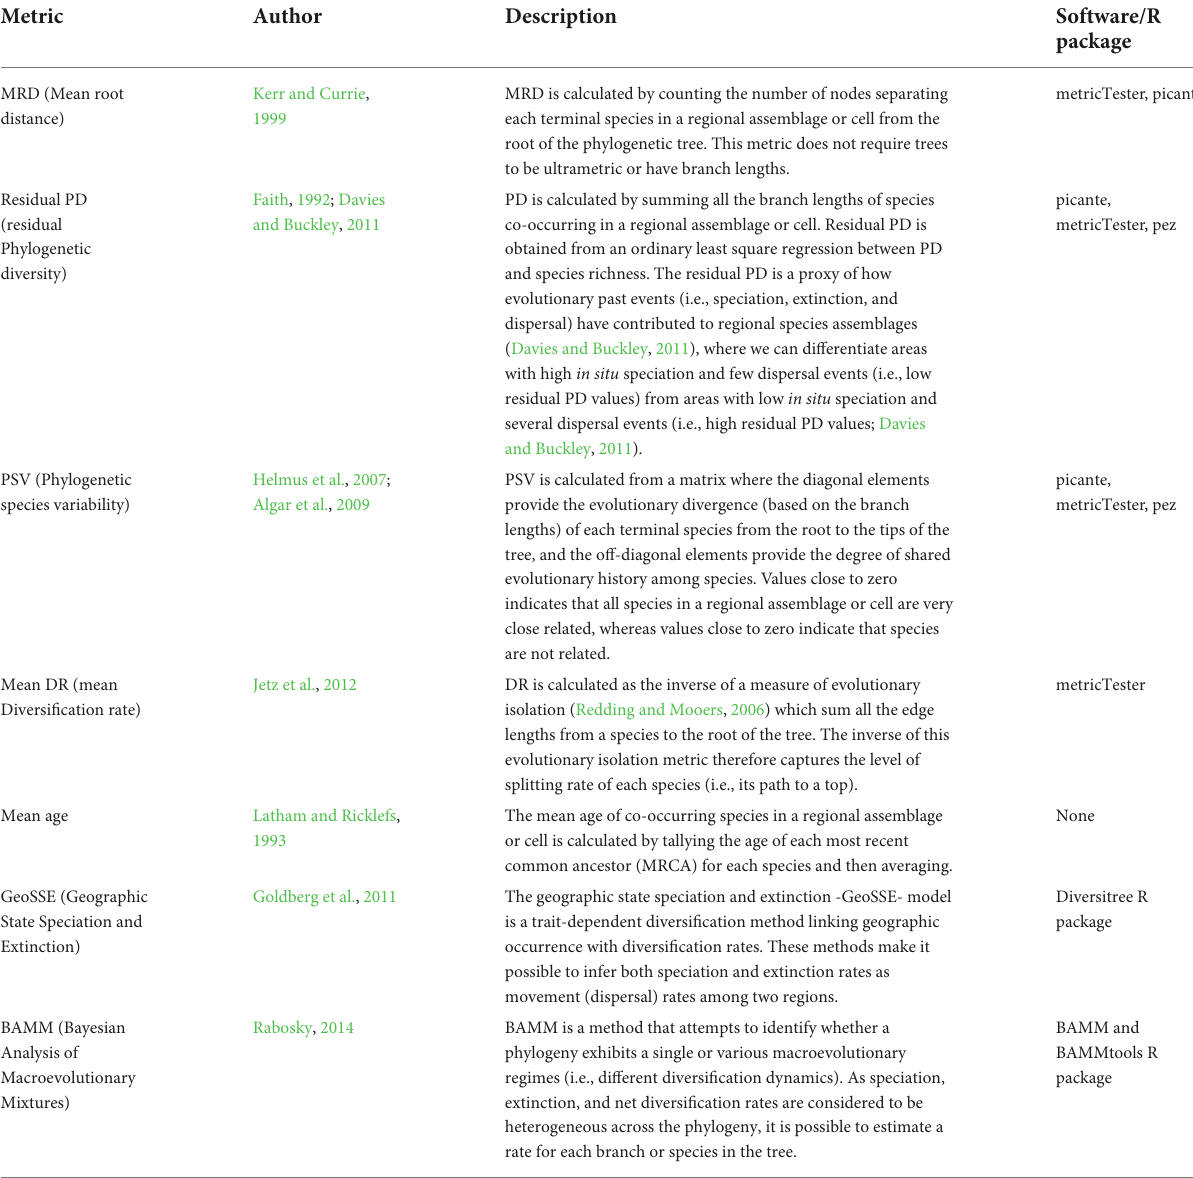
TABLE 1 Phylogenetic metrics and approaches used in macroecological studies to test the role of phylogenetic niche conservatism (PNC) and regional diversification (RD) shaping present-day species richness patterns across